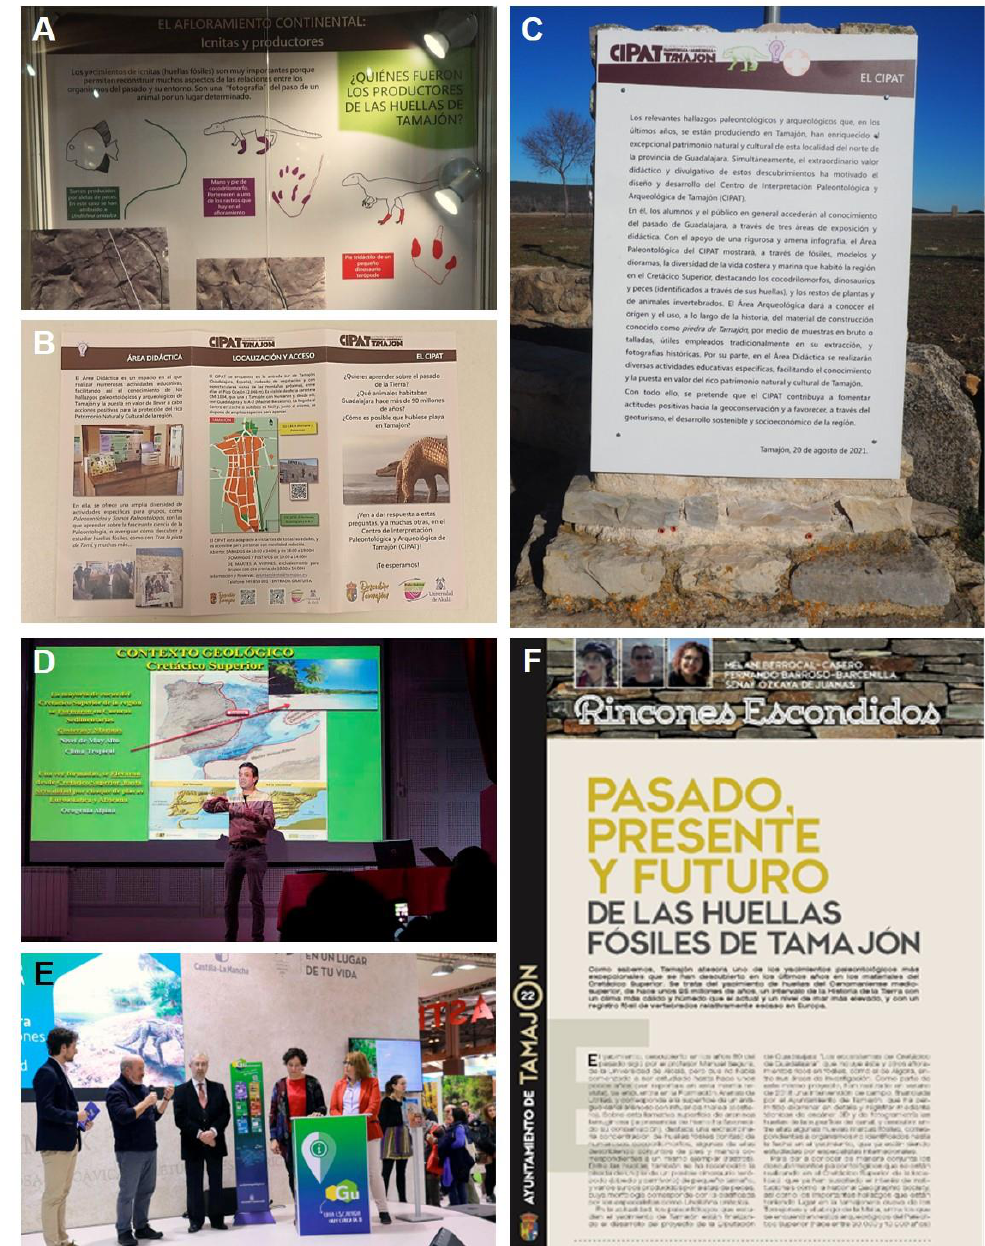
Figure 7. ( A ) Detailed view of the background designed for the interior of the display case for the continental outcrop (track site) of the Paleontological Area of the Paleontological and Archaeological Interpretation Centre of Tamajón (CIPAT); ( B ) The triptych with information about the CIPAT, which is being distributed free of charge to all visitors; ( C ) Photograph of the panel at the exterior of the interpretation centre, which presents the CIPAT and invites the visitor to enter and get to know it; ( D , E ) Outreach of different aspects of the CIPAT at the paleontological weekend organised by the Tamajón town council in September 2018 ( D ), and at the Guadalajara Day organised by the International Tourism Fair (FITUR) in January 2019 ( E ); ( F ) Outreach publication on the content and the scientific and didactic potential of the Cretaceous track surface [10].